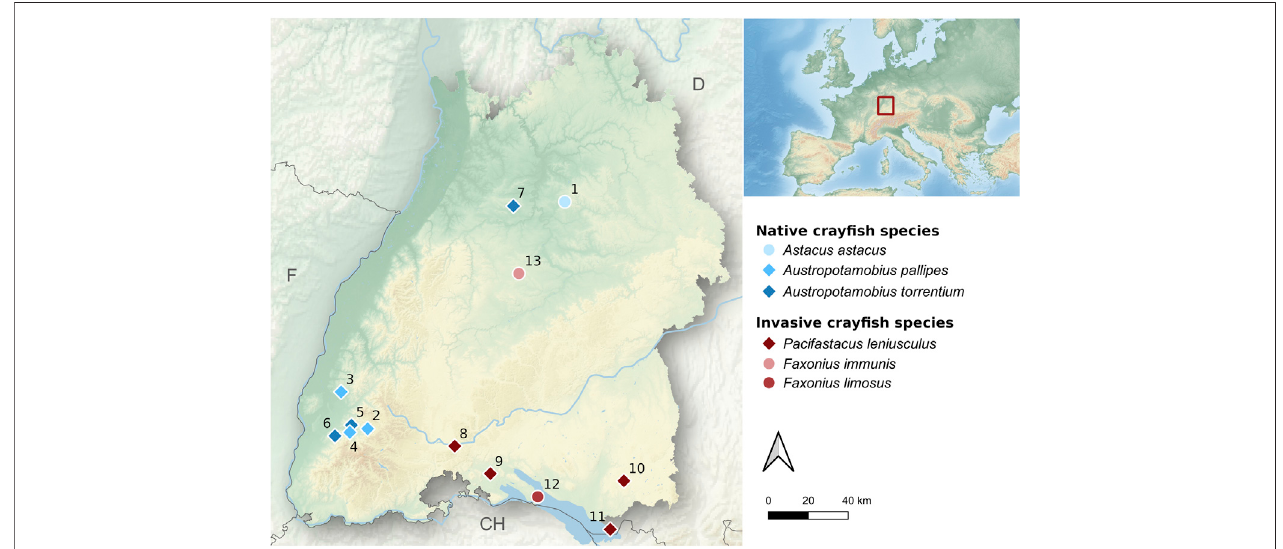
FIGURE 1 | Map of the study area (federal state of Baden-Württemberg, southwestern Germany) showing all investigated water bodies. Native and invasive cray fi sh populations are presented by blue- and red-colored symbols, respectively. Sampling sites with diamonds were used for spatio-temporal eDNA sampling, whereas sampling sites with circles were only used for primer evaluation. See Table 2 for habitat characteristics.